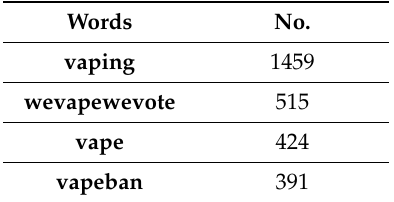
Table 4. Most frequently occurring